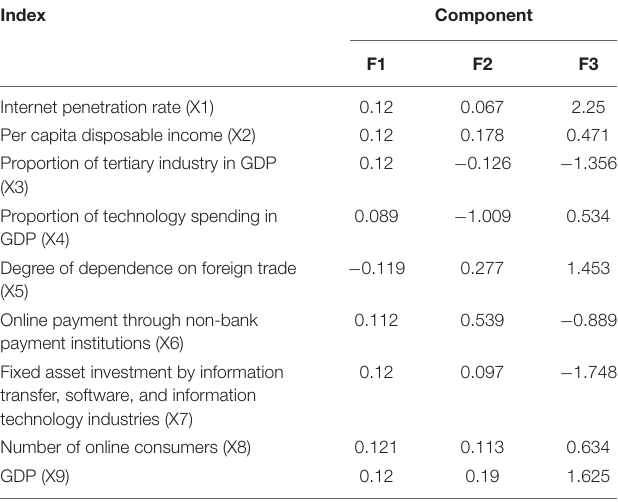
TABLE 9 | Component score coefficient